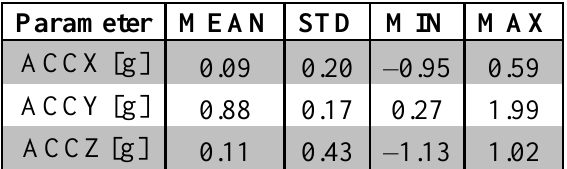
Table 7. Statistical analysis of experimental data acquired during 60 s trees